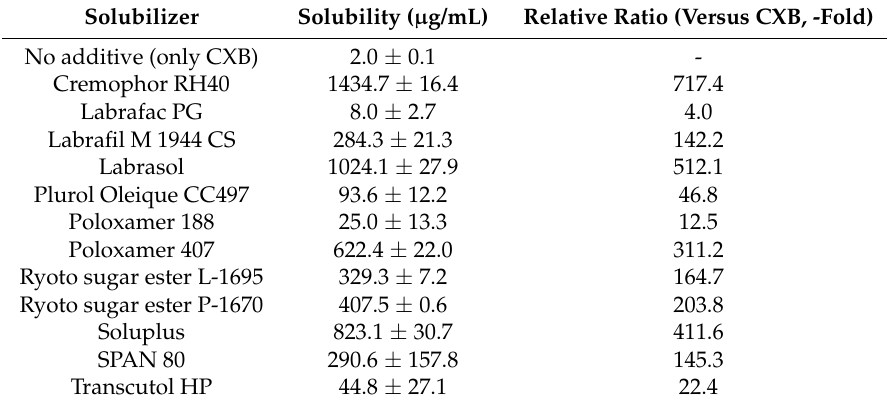
Table 1. Saturated solubility and its relative ratio of celecoxib (CXB) in aqueous solutions with various solubilizers (5%) ( n =